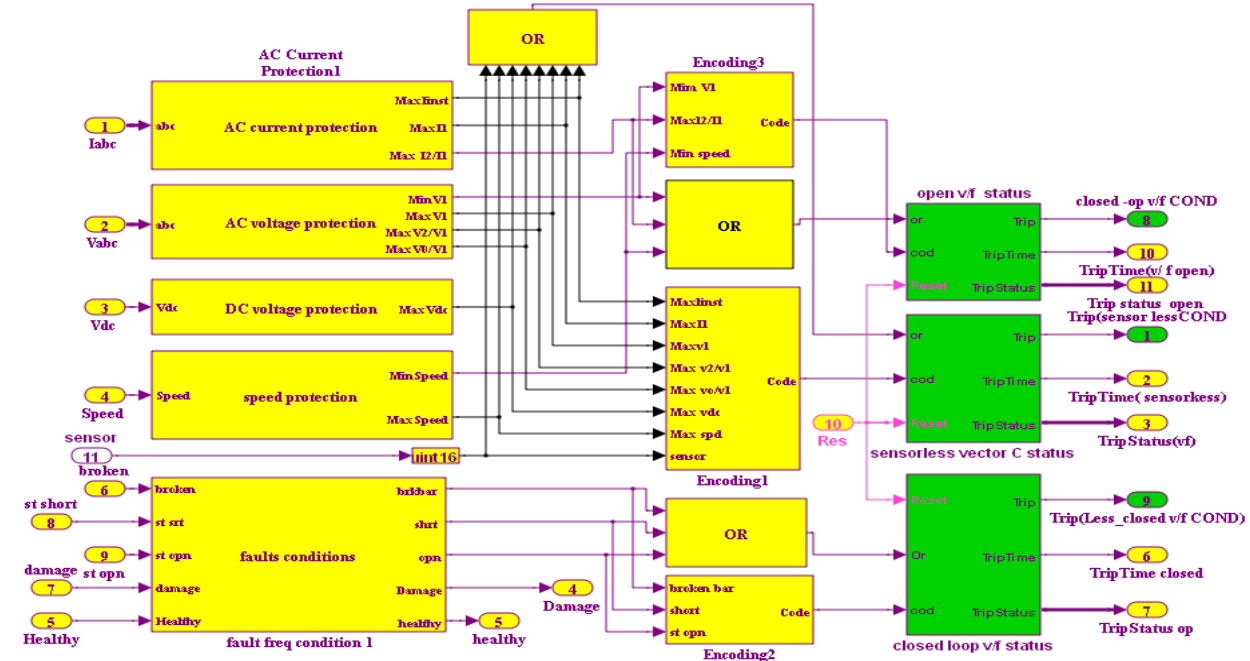
Figure 11. Simulink model of FTC